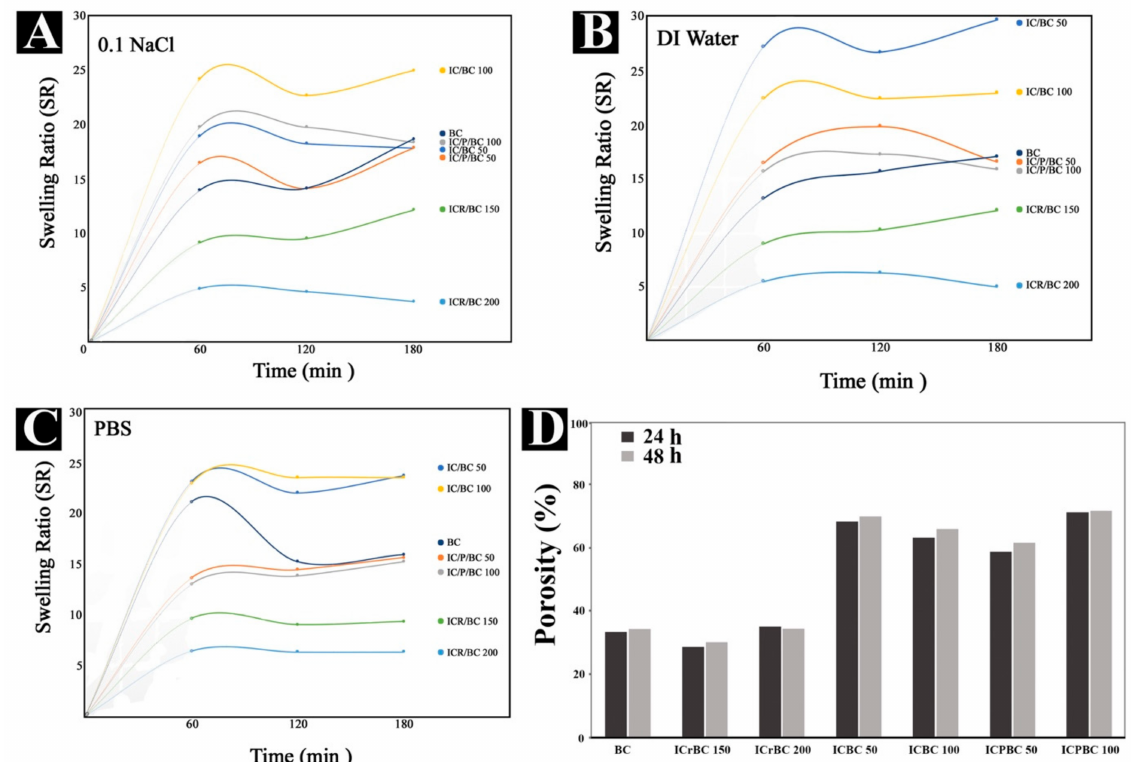
Figure 1. Swelling performance of ( A ) 0.1 M NaCl solution, ( B ) DI water, ( C ) PBS solution of the freeze-dried hydrogel composites. ( D ) Porosity% of